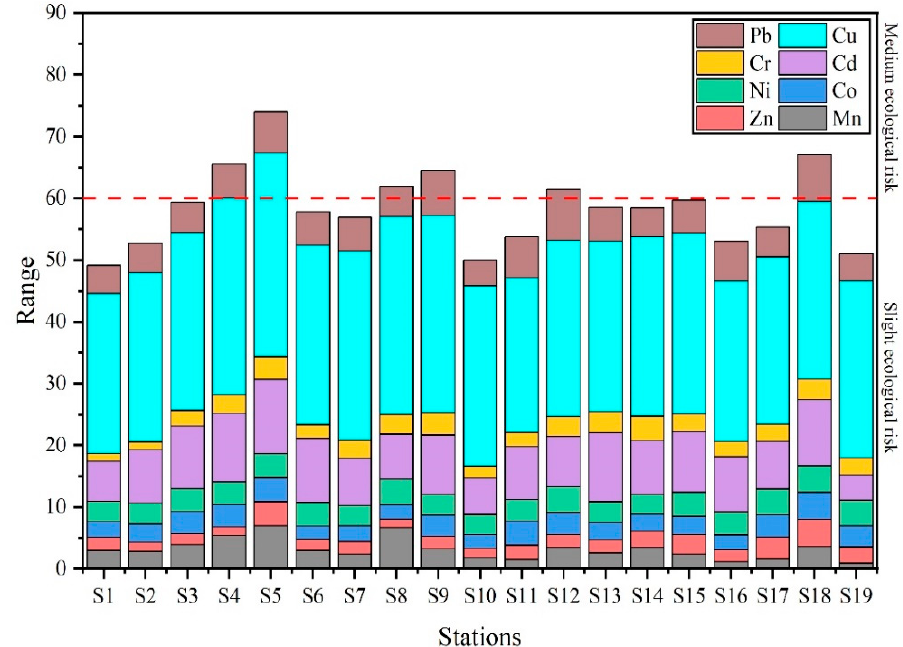
Figure 6. Values of potential ecological risk index ( RI ) at different stations.